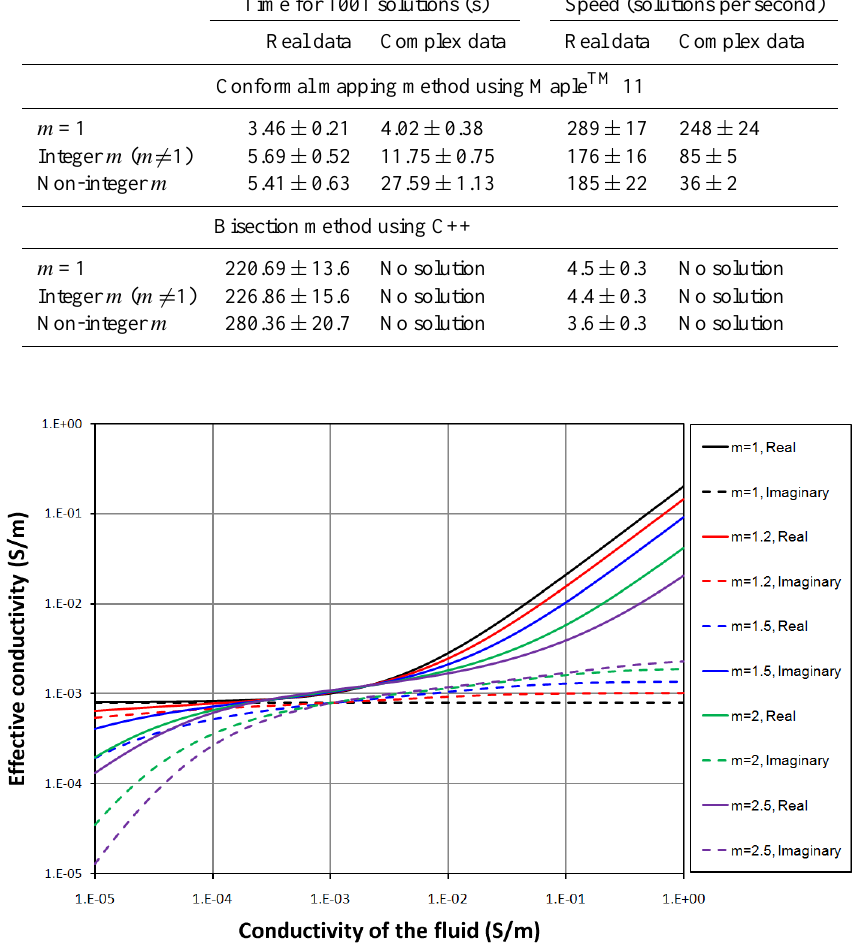
Fig. 4. Complex effective electrical conductivity σ eff calculated as a function of porosity at 1001 points for the Bussian equation using the conformal mapping method for φ =0.2; m =1, 1.2, 1.5, 2, 2.5; σ m =10 − 3 + i 10 − 3 S/m; 10 − 5 S/m ≤ σ f ≤